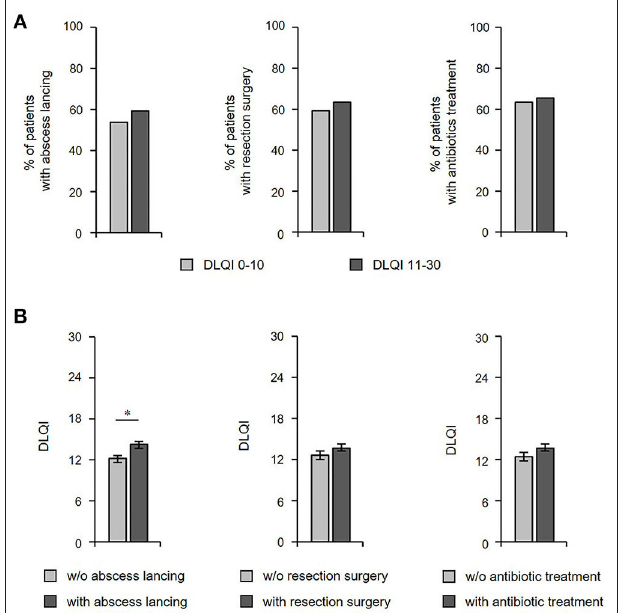
FIGURE 7 | DLQI scores are not associated with current type of treatment. (A) The frequency of HS patients ( n = 435) who had received therapeutic abscess lancing (left), resection surgery (middle) and antibiotic treatment (right) in patients with small/moderate (DLQI ≤ 10) vs. very/extremely large (DLQI > 10) QoL impairment is provided. (B) DLQI scores of patients with HS who have or have not undergone the respective therapeutic regimen are indicated using mean ± SEM ( n = 435). The significance of differences was assessed using the Mann-Whitney U test (* P < 0.05). DLQI, Dermatology Life Quality Index.